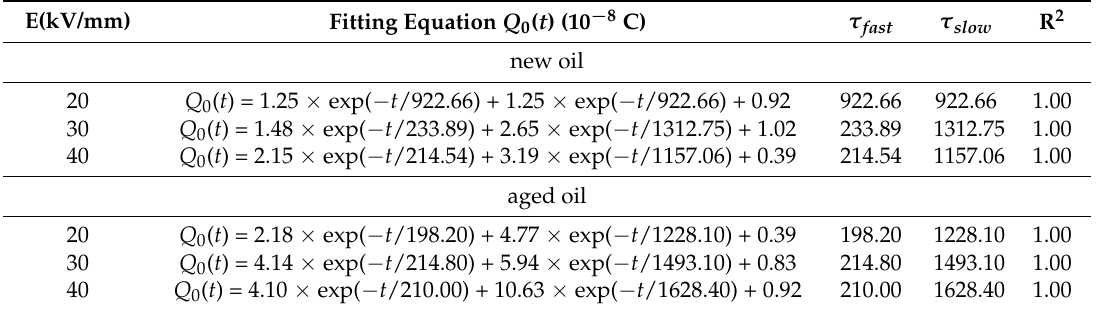
Table 3. The charge detrapping expression based on the double order exponential fitting analysis for oil impregnated insulation paper with new and aged